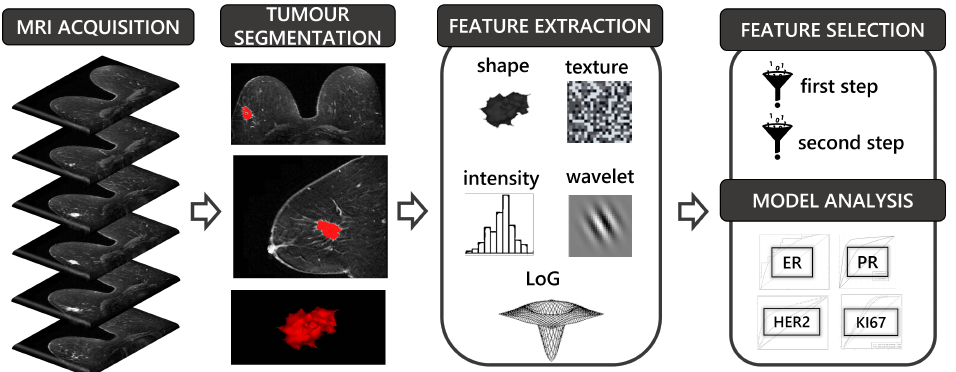
Figure 1. The steps of the adopted radiomics pipeline. They include MRI acquisition, tumor segmen- tation, feature extraction, feature selection, and model